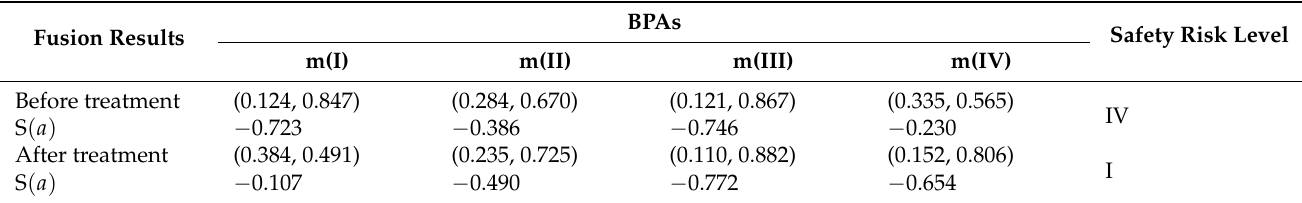
Table 9. Fusion results before and after treatment of karst development area.